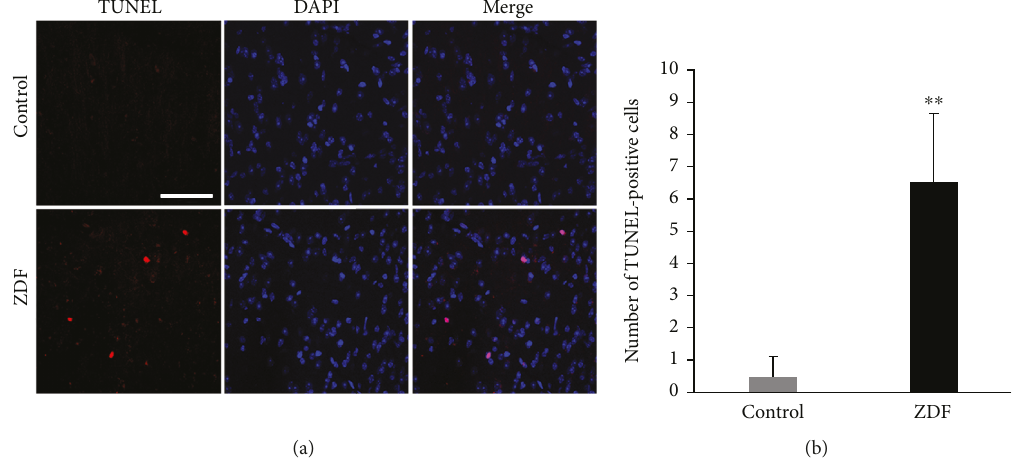
Figure 7: The occurrence of apoptosis in the auditory cortex of rats in the ZDF and control groups. (a) Representative images show the TUNEL-positive cells (red) in the auditory cortex of rats in the ZDF and control groups using TUNEL staining. Scale bar = 50 μ m . (b) Quanti fi cation of TUNEL-positive cells in the auditory cortex of rats in the ZDF and control groups. Data are expressed as mean ± SD ( n = 4 ). ∗∗ P < 0 01